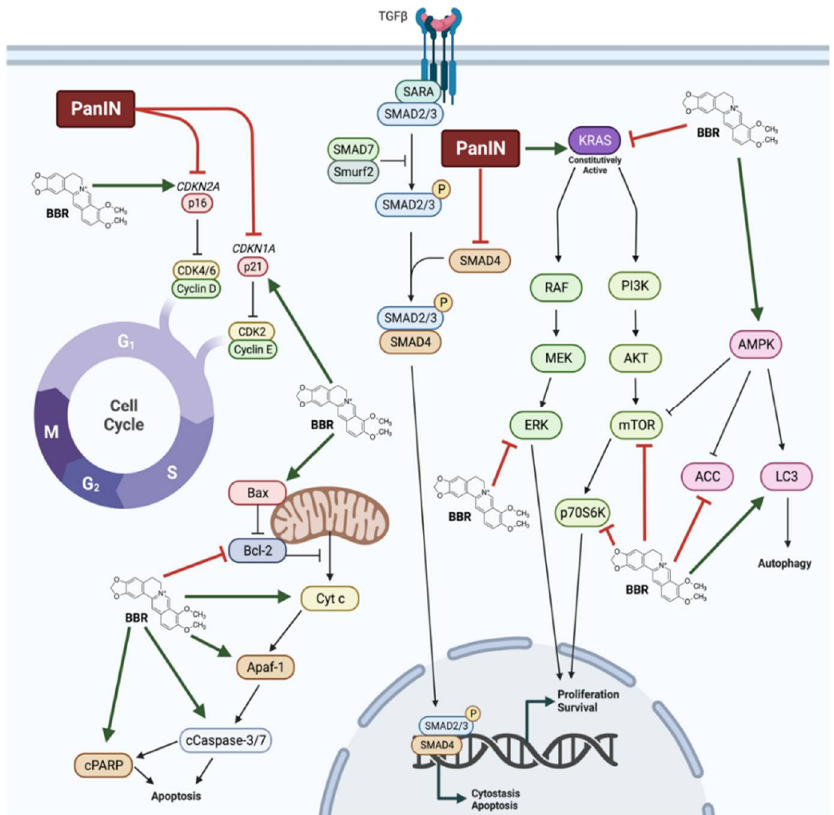
Figure 5. Summary of the effects of berberine in pancreatic cancer cells. Berberine (BBR) was shown to restore p16 and p21 function in pancreatic intraepithelial neoplasia (PanIN). BBR increased AMP- activated protein kinase (AMPK) and apoptosis signalling and decreased oncogenic Kirsten rat sarcoma virus (KRAS), extracellular signal-regulated kinase (ERK), mammalian target of rapamycin (mTOR), and ribosomal protein S6 kinase (p70S6K) signalling, culminating in decreased proliferation and survival, and increased apoptosis, cytostasis, and autophagy.